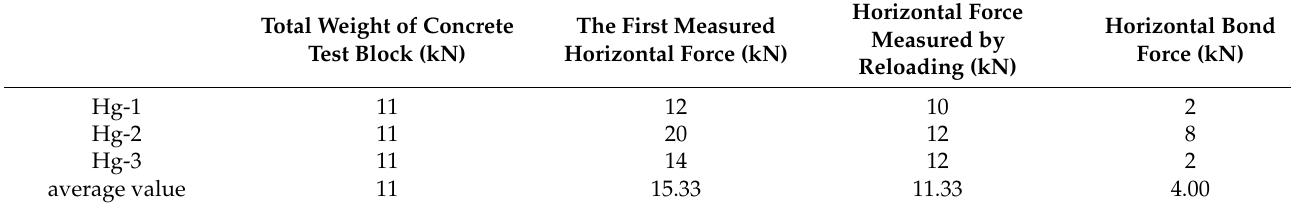
Figure 13. Horizontal jack loading curve of Hg specimen. Table 4. Horizontal force of the specimen with geotextile on the contact surface.